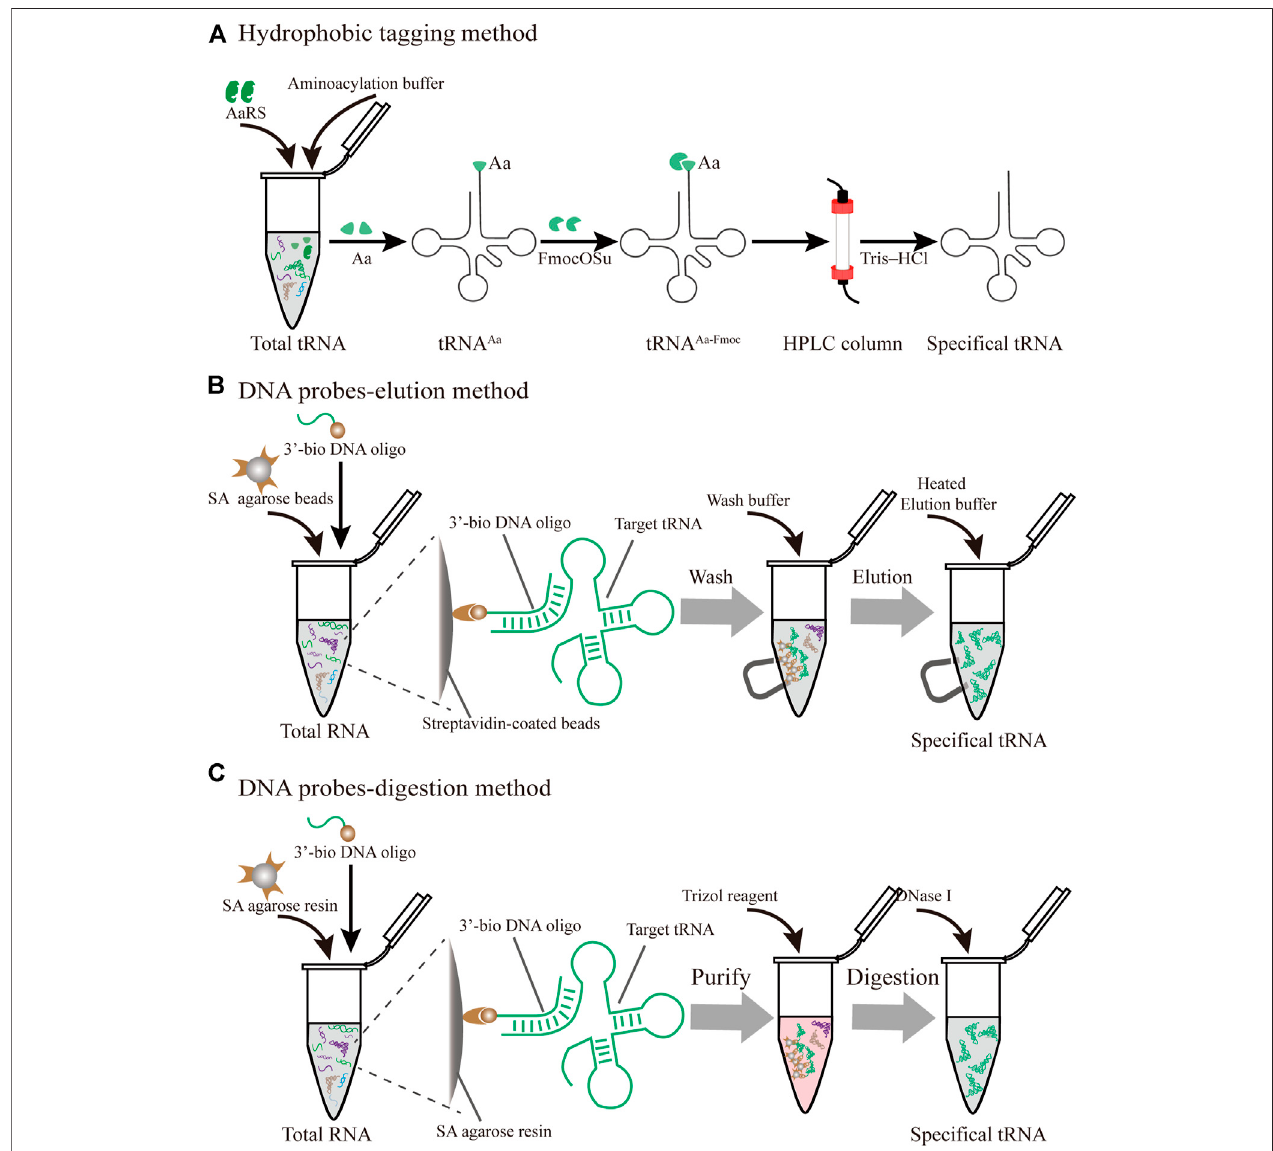
FIGURE4| Differentstrategiesforthepuri fi cationofspeci fi cindividualtRNAsproduced invivo (A) Hydrophobictagging method.Thehydrophobictag(FmocOSu) can react with the free amino group on the aminoacylated tRNA, which can be separated from other tRNAs due to its high molecular weight, then puri fi ed and de- acylated (B) DNA probe-elution method. Biotinylated DNA oligonucleotides are immobilized on streptavidin sepharose beads, and individual tRNAs are isolated from total RNA using a magnet (C) DNA probe-digestion method. The hybridized tRNAs-oligo complex was puri fi ed from the tRNAs-oligo-resin complex using Trizol. Individual tRNAs can be released using DNase